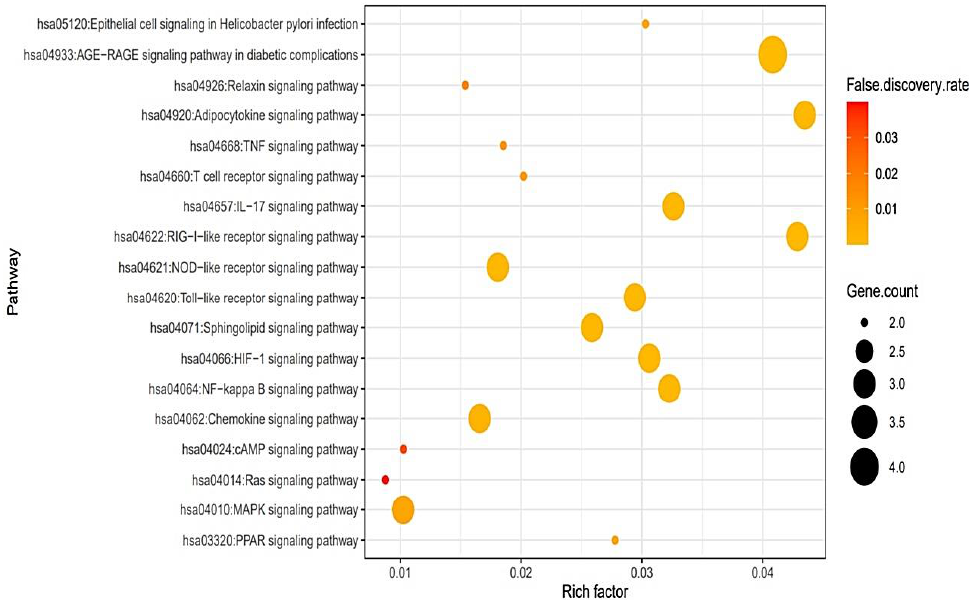
Figure 5. A bubble plot of 18 signaling pathways related to the response to LE bioactive compounds against COVID-19.